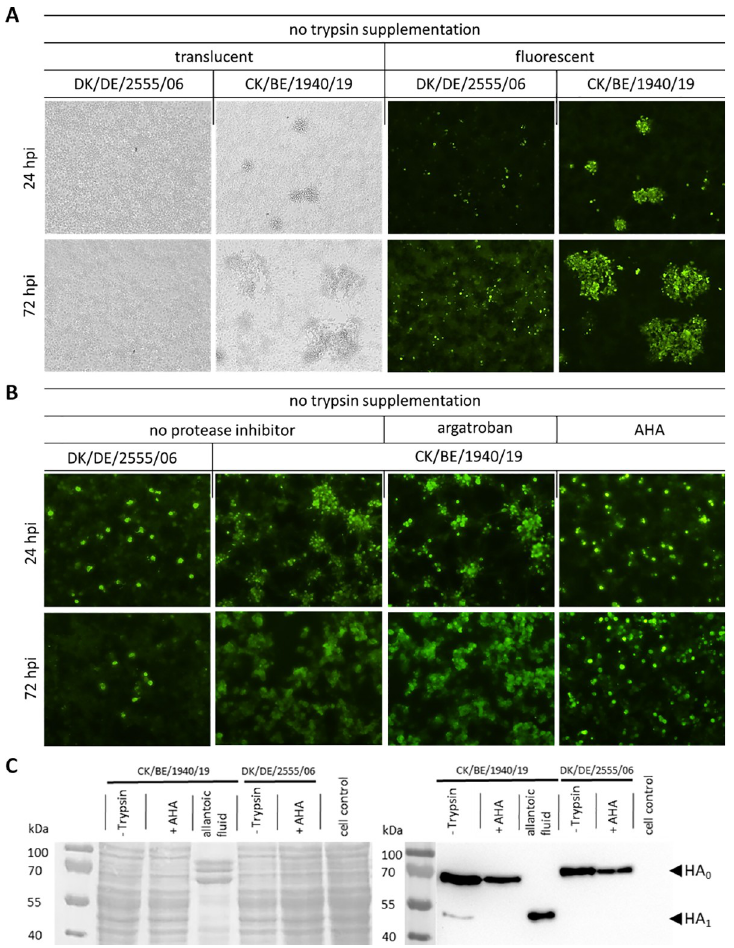
Fig 6. Trypsin-independent spread and HA 0 cleavage of CK/BE/1940/19 is blocked by 6-aminohexanoic acid. (A) Immunofluorescent plaque assays on LMH cells were conducted with either DK/DE/2555/06 (H3N1) or CK/BE/1940/ 19 (H3N1) isolate. Cells were formalin fixated following incubation for 24 or 72 hours post inoculation (hpi). Cytopathogenic effect (CPE) was only observed for the CK/BE/1940/19 isolate by translucent light microscopy (left). Immunostaining confirmed IAV antigen is colocalized with visible CPE for the CK/BE/1940/10. Time-dependent increase of plaque size indicates ongoing virus spread. Only single individual cells stained positive with DK/DE/2555/ 06 and no increase in number of infected cells was detectable. (B) Trypsin-independent replication of CK/BE/1940/19 can be blocked by 6-aminohexanoic acid (AHA) supplementation in immunofluorescence plaque assays. While the LPAIV reference virus DK/DE/2555/06 only infect single cells without trypsin supplementation, the CK/BE/1940/19 H3N1 efficiently spread without trypsin and/or argatroban supplementation, a thrombin specific inhibitor. In contrast when cultivated with AHA, a plasmin specific inhibitor, CK/BE/1940/19 becomes restricted to single cell infection. (C) In vitro proteolytic cleavage of HA 0 without trypsin-supplementation was prevented by AHA as shown by western blot. (left) Ponceau S stain proteins unspecific, confirming comparable protein loads of cell lysate at the membrane. (right) Chemiluminescent detection following incubation with H3 specific antibody (binding within HA 1 ). There is a clear band at size of 70 kDa for the cell lysates of CK/BE/1940/19 and DK/DE/2555/06 inoculated cells, which representing the uncleaved HA 0 protein. For CK/BE/1940/19, there is an additional band right below 55 kDa, representing the HA 1 , indicating proteolytic cleavage of HA 0 . This band do not appear when cultivated with AHA supplementation. In contrast, the allantoic fluid stock of CK/BE/1940/19 only, exhibits a strong HA 1 specific signal.